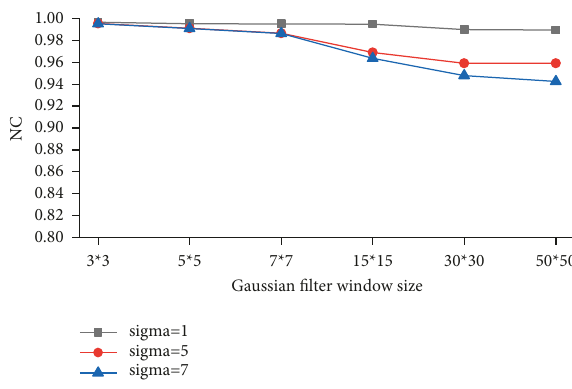
Figure 11: NC value under Gaussian filter attack.